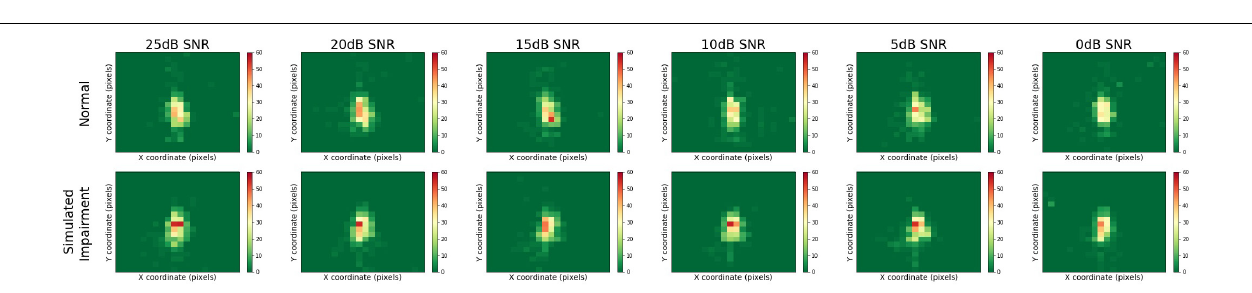
FIGURE 4 | Mean fixation durations and total fixations presented across levels of SNR (measured in dB) and hearing impairment.